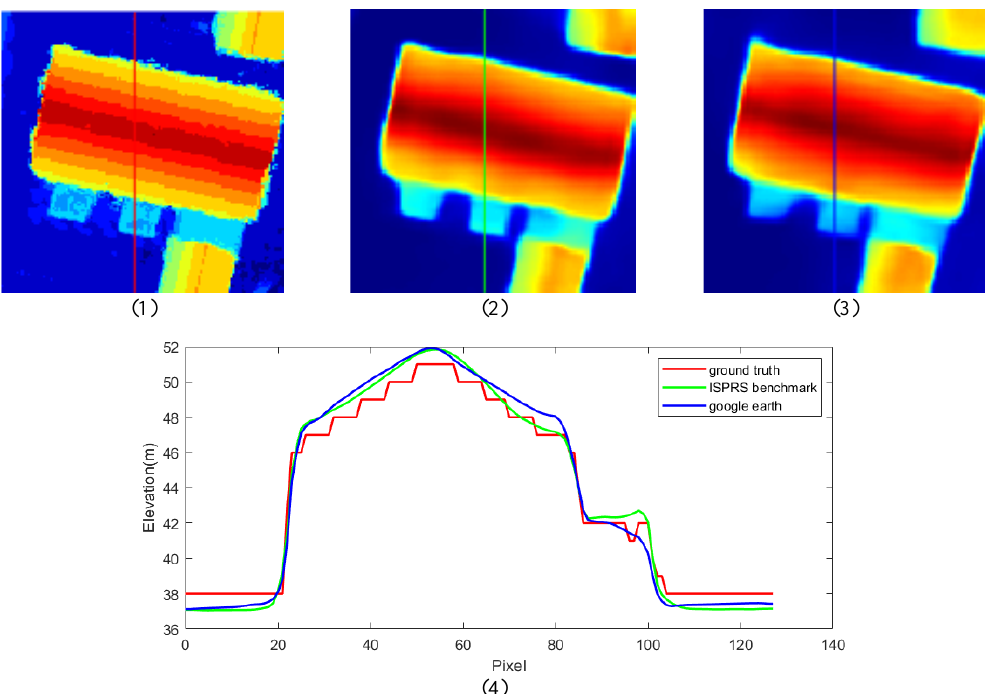
Figure 4 . The comparative results in Example 1: (1) Ground-truth image, (2) ISPRS benchmark, (3) Google earth image, (4) The 3 different profiles.